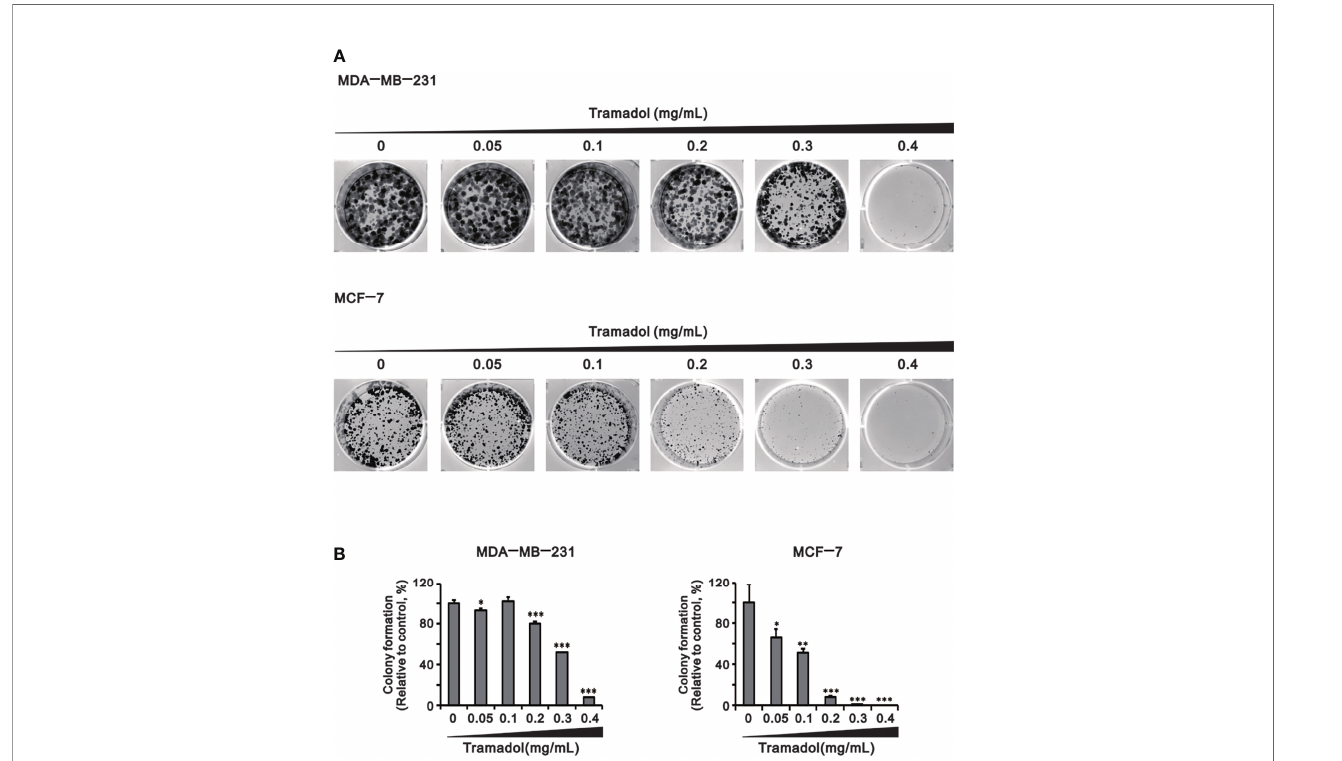
FIGURE 3 | Analysis of the effect of tramadol on the colony-formation ability of human breast cancer cells. (A, B) MDA-MB-231 and MCF-7 cells were treated with tramadol (0, 0.05, 0.1, 0.2, 0.3 and 0.4 mg/mL) for 14 days. Bars depict the mean ± SD of three independent experiments. * p < 0.05, ** p < 0.01 and *** p < 0.001 (Student ’ s t -tests). Bars depict the mean ± SD of three independent